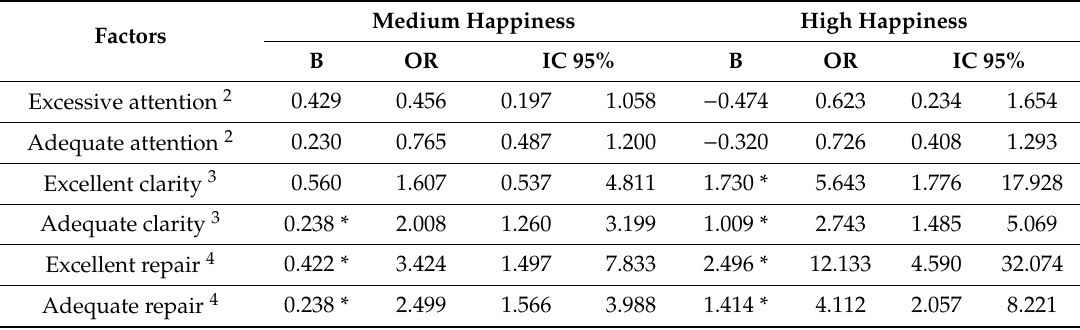
M = mean, SD = standard deviation. P = Percentile. Table 2. Multinomial logistic regression model examining the probability of perceiving low happiness according to the degree of emotional attention, clarity, and